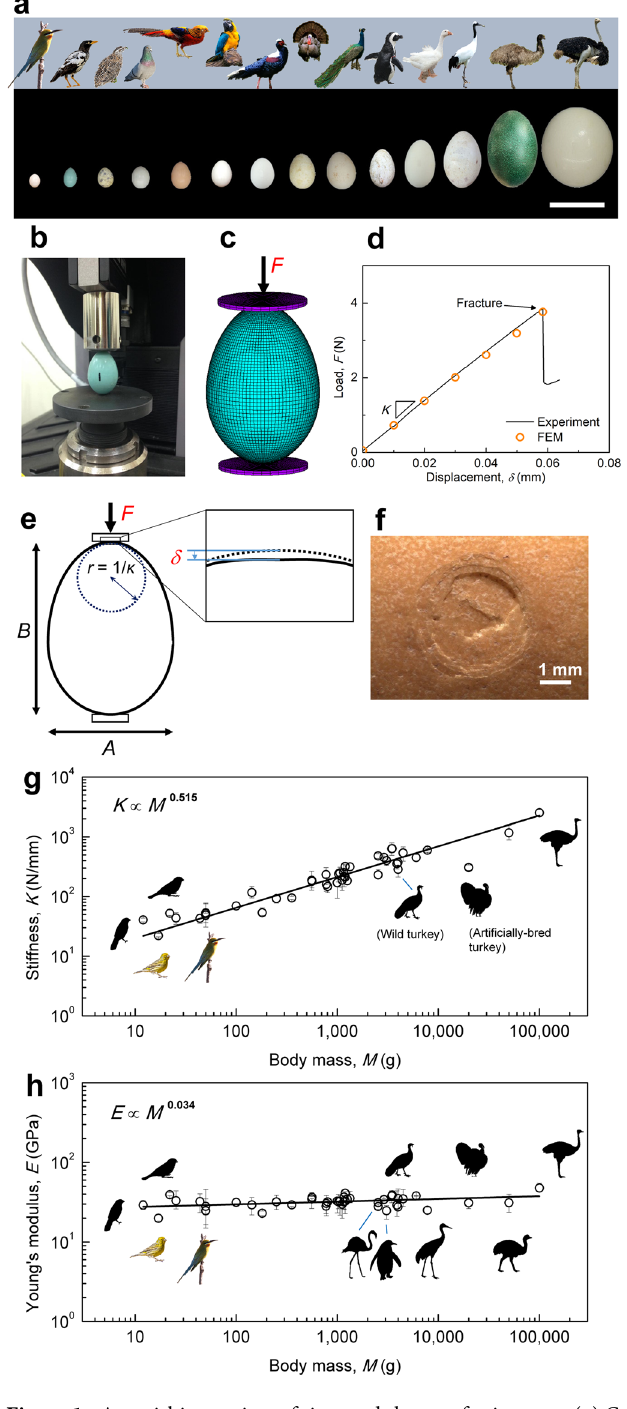
Figure 1. Astonishing variety of sizes and shapes of avian eggs. ( a ) Comparison of 14 representative eggs. What do they have in common? scale bar: 100 mm. Left to right: Blue-tailed bee-eater ( Merops philippinus ), Javan myna ( Acridotheres javanicus ), common quail ( Coturnix coturnix ), rock dove ( Columba livia ), golden pheasant ( Chrysolophus pictus ), Blue-and-yellow Macaw ( Ara ararauna ), Swinhoe’s pheasant ( Lophura swinhoii ), wild turkey ( Meleagris gallopavo ), Indian peafowl ( Pavo cristatus ), African penguin ( Spheniscus demersus ), domestic goose ( Anser sp .), red-crowned crane ( Grus japonensis ), emu ( Dromaius novaehollandiae ), and ostrich ( Struthio camelus ). ( b – d ) Representative experimental setup showing a javan myna egg under compression test ( b ), its corresponding FEM model ( c ), and the load-displacement curve ( d) . ( e ) Schematic of a deformed egg sample under compression test. ( f ) Representative image of a fractured egg of silver pheasant ( Lophura nycthemera ) after the compression test. The fracture almost always occurs at the top pole and exhibits a pattern known as “ring cracks” 37 , which are small compared to the egg length ( ≈ 50 mm). ( g ) Experimental stiffness along the long axis. ( h ) Young’s modulus E . The E of each egg sample is estimated by simulating the compression test by FEM. Our results reveal that E is quite constant (32 ± 5 GPa) for a wide range of body mass (12 − 100,000